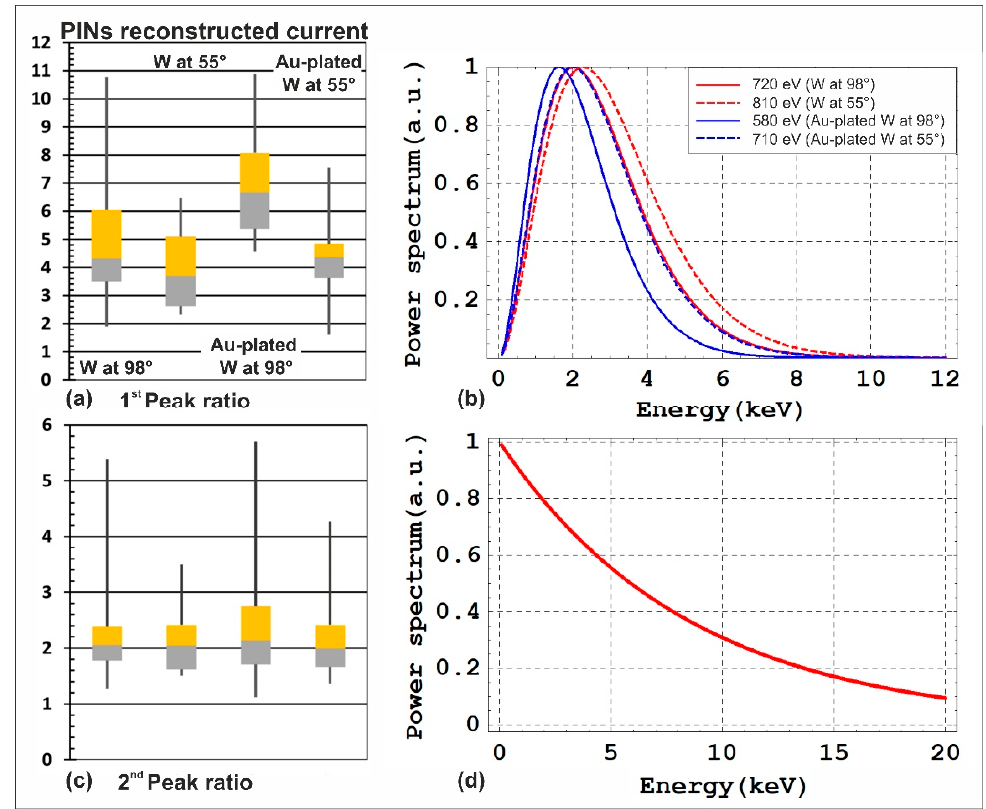
Figure 6. ( a ) Boxplot of the reconstructed current corresponding to the 1st X-ray burst peak ratio. ( b ) Power spectrum as a function of energy for the four examined configurations, using the median values of the ratios. ( c ) Boxplot of the reconstructed current corresponding to the 2nd X-ray burst peak ratio. ( d ) The power spectrum for ratio 2.5.